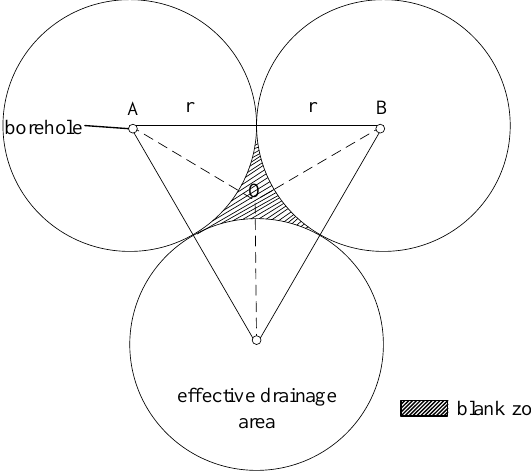
Figure 4. Schematic diagram of borehole gas extraction influence area.